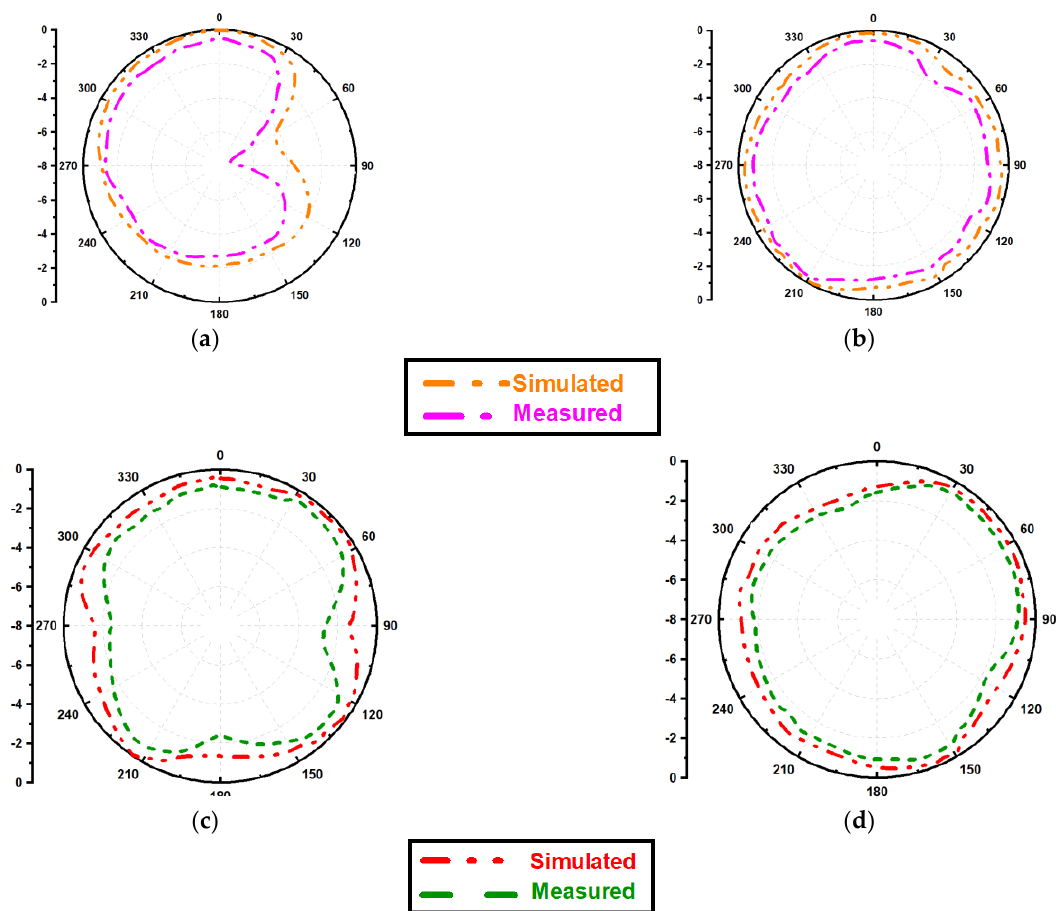
Figure 10. Normalized E-field [( a , b )] and H-field [( c , d )] radiation pattern at 3.63 GHz and 4.94 GHz frequencies.